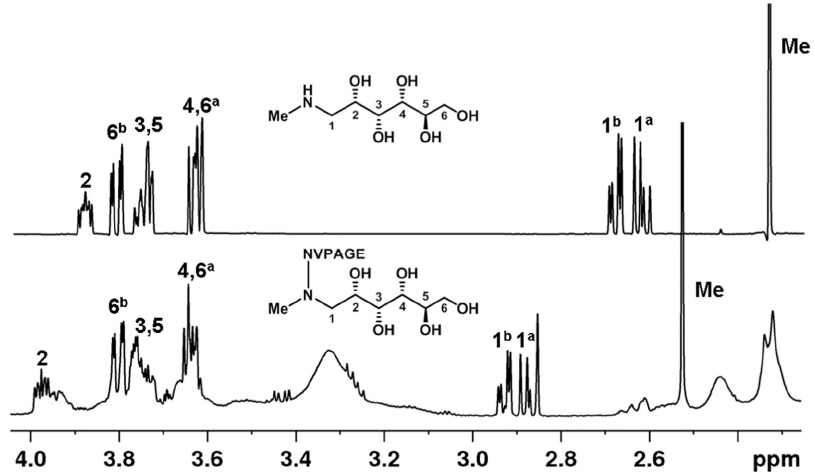
Figure 5. Fragments of 1 H NMR spectra of meglumine and polymer-based conjugate.